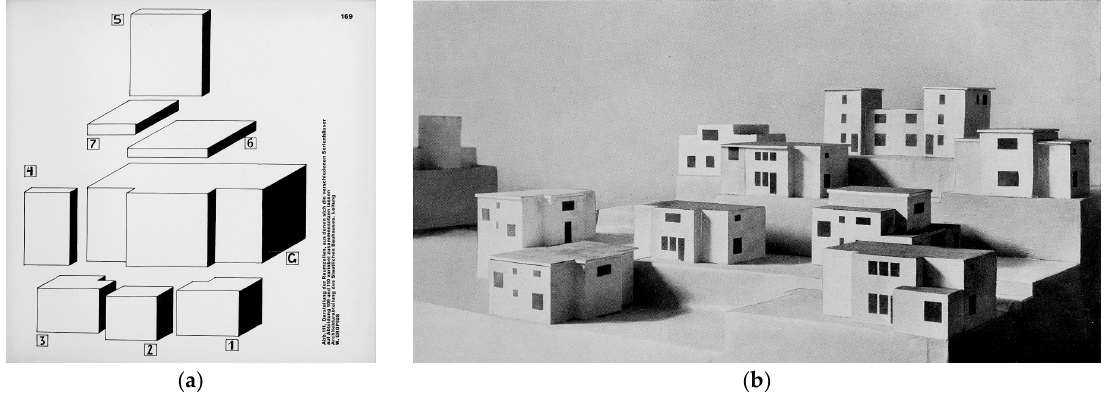
Figure 6. Walter Gropius and Fred Forbát: “Honeycomb System” (‘Wabenbau’), 1922. Images from (Nierendorf 1923, pp. 169–70).